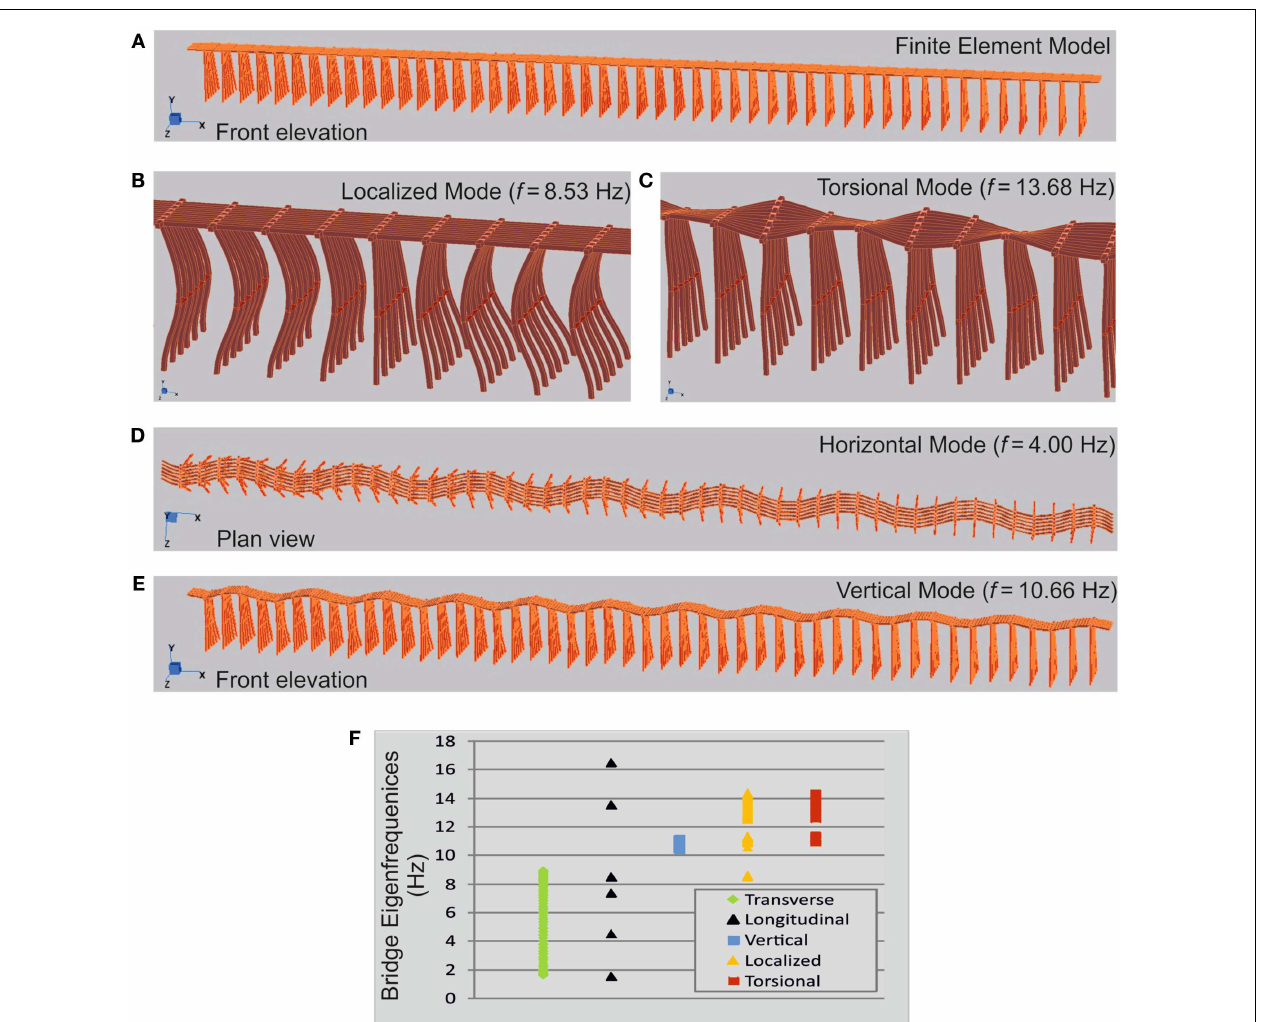
(D) Horizontal flexural mode involving transverse displacement of the upper deck; f = 4.00Hz. (E) Vertical flexural mode involved in the bridge failure; f = 10.66Hz. (F) , Eigenfrequencies of the five types of vibration modes: transverse flexural and longitudinal horizontal modes, vertical, localized in the supporting pillars and